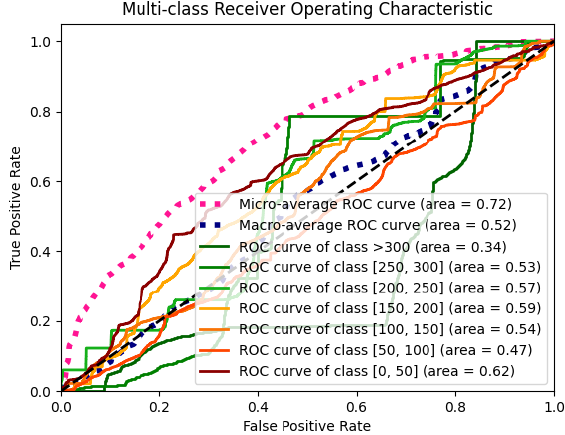
Figure 14. Multiclass receiver operating characteristics (ROC)